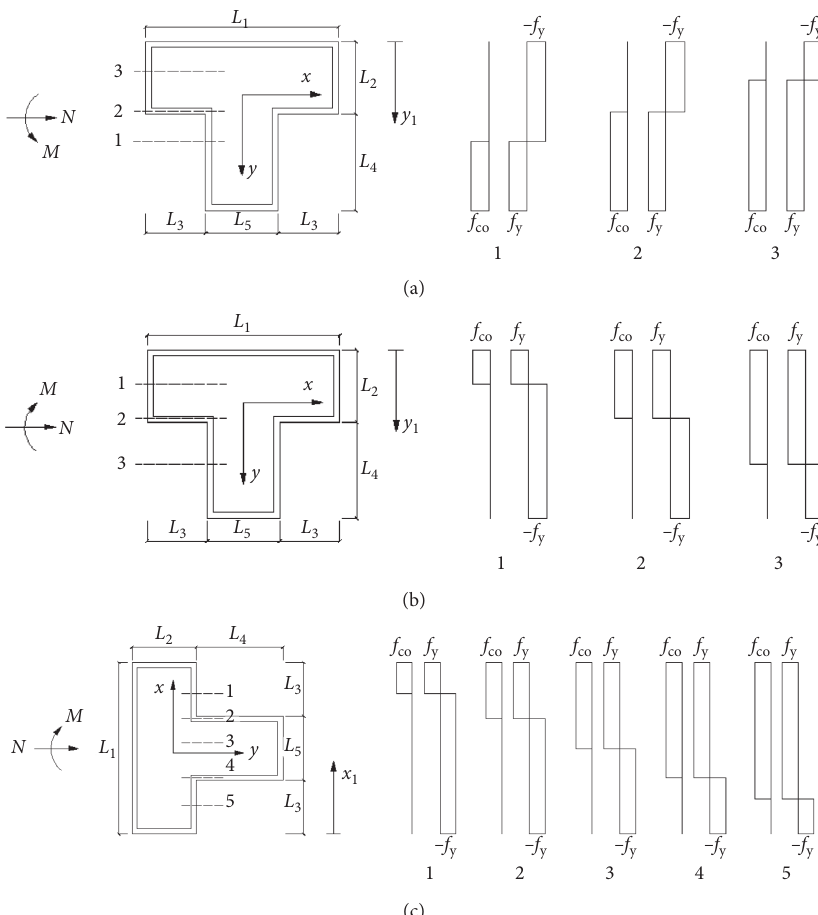
Figure 19: Cross-sectional stress distribution. (a) In forward direction loading. (b) In reverse direction loading. (c) In x direction loading. Table 1: The parametric values. Fixed Parameter Values